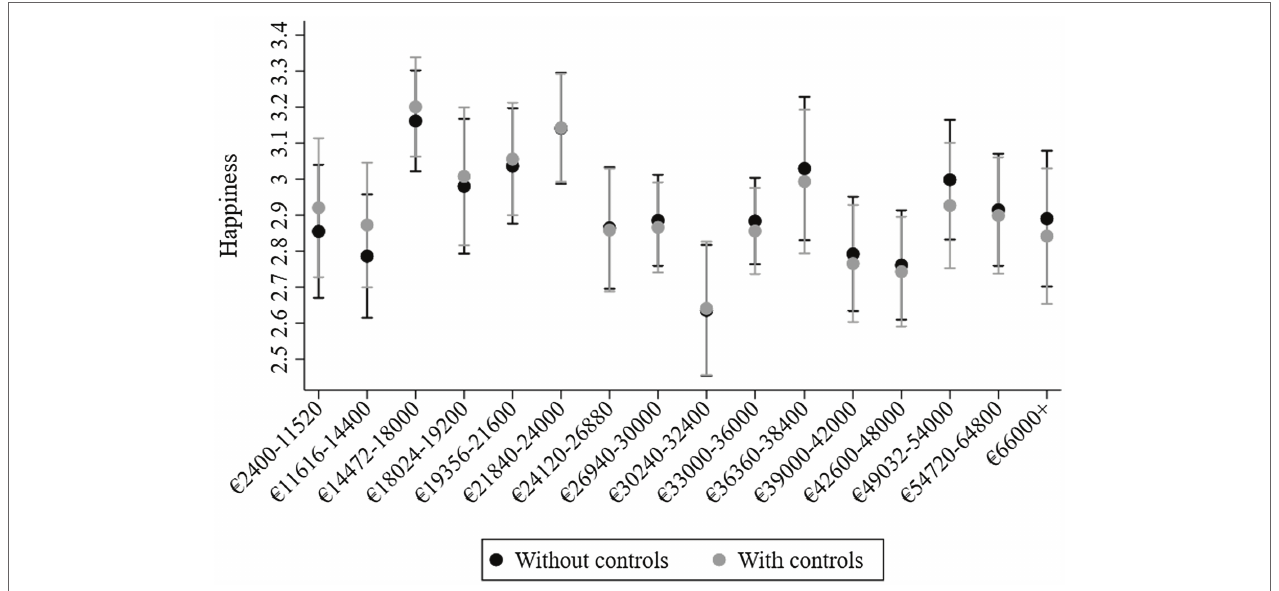
FIGURE 3 | Predicted values of average person-year happiness from GSOEP DRMs at 16 quantiles of income (Income 4) without and with controls. Covariates at means. 95%